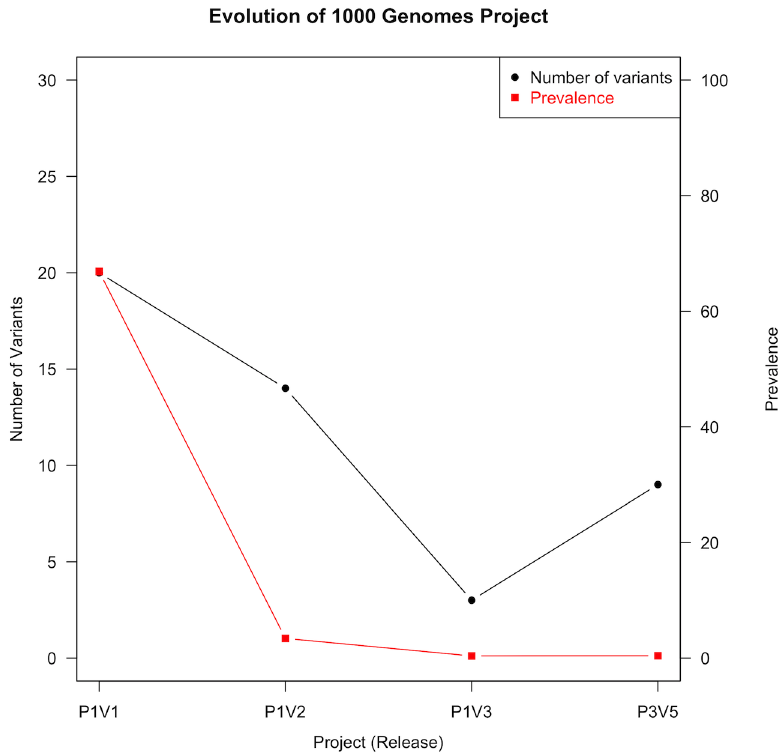
Fig 1. Influence of 1000 genomes project evolution on titin truncation prevalence. Abbreviations: P1V1 – phase 1 version 1; P1V2 – phase 1 version 2; P1V3 – phase 1 version 3; P3V5 – phase 3 version 5.